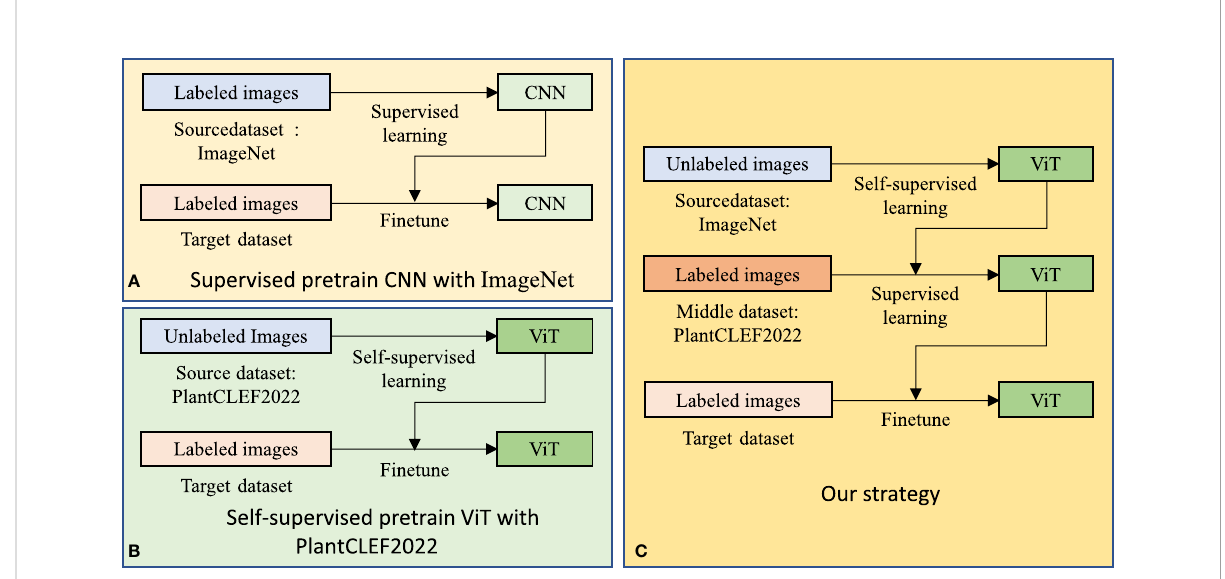
FIGURE 5 Transfer learning strategies for plant disease recognition. Our strategy differs from the current popular transfer learning strategy (A) in the source dataset, model, and loss function. Furthermore, we adopt dual transfer learning (C) to save computation time by utilizing the public pre-trained model, compared to (B)